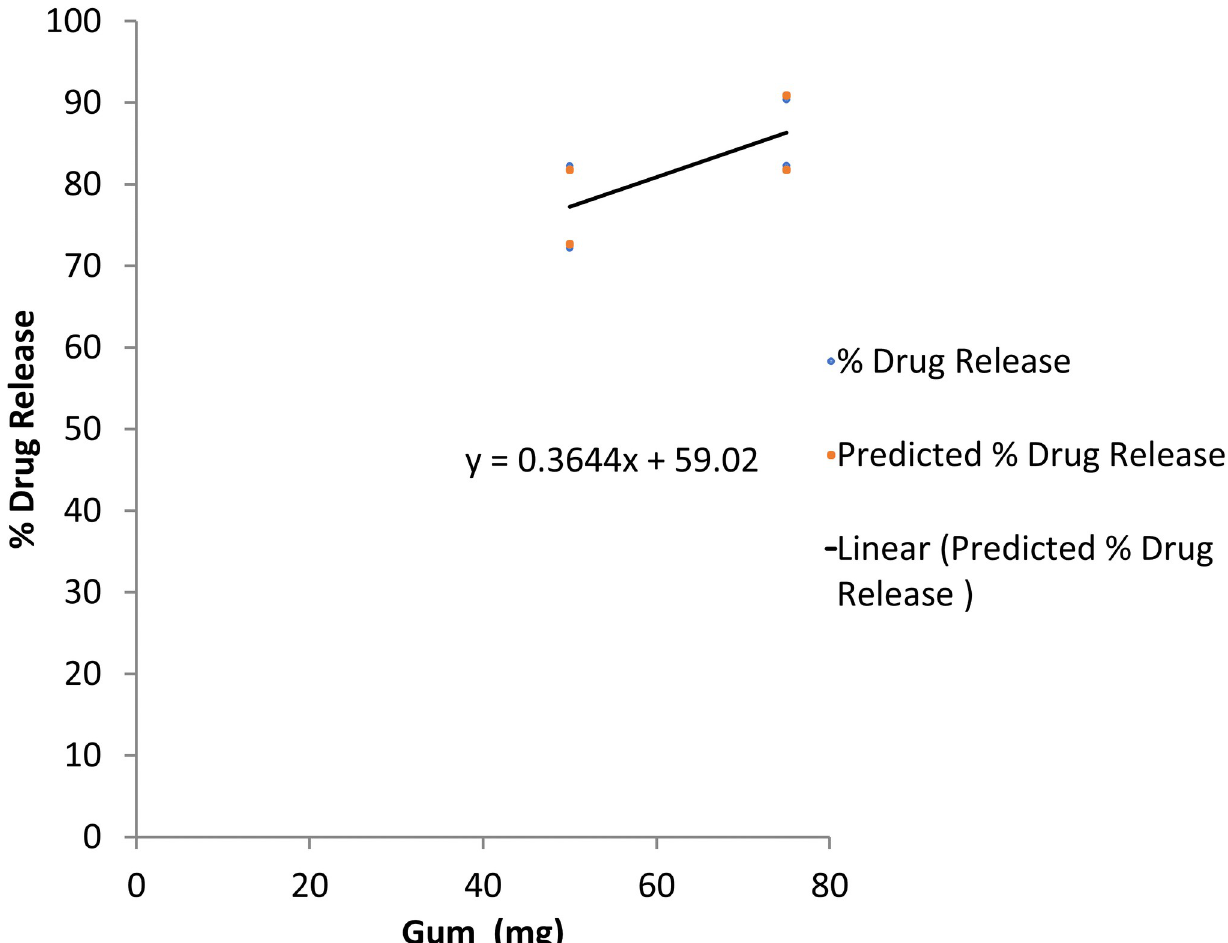
Fig 8. Line fit plot for the response of percent drug dissolution with Prunus domestica gum.